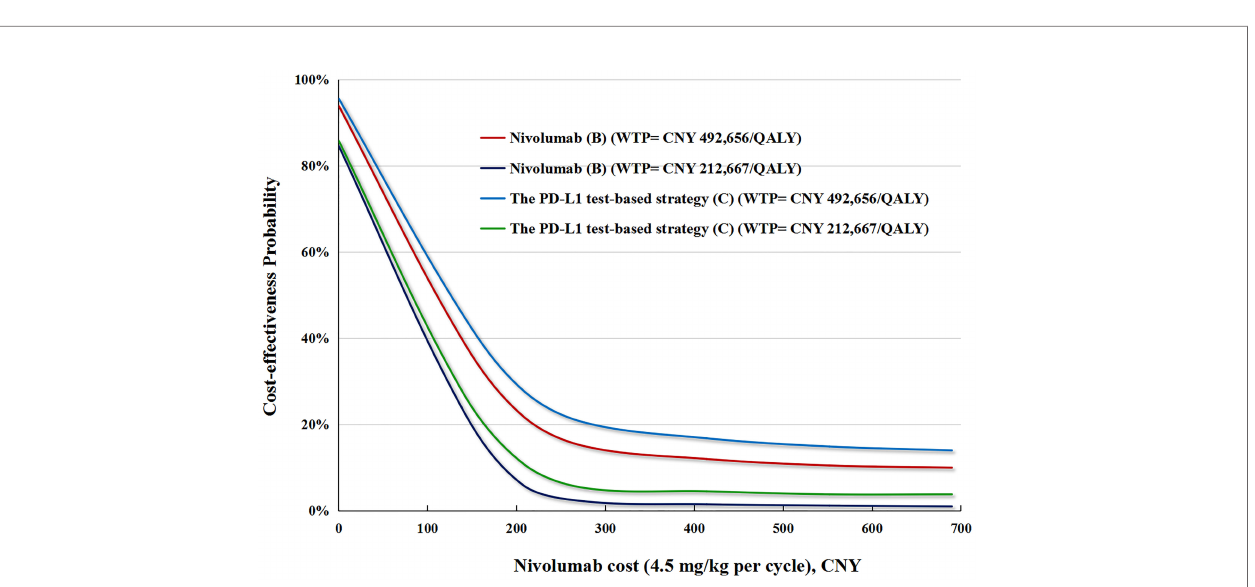
FIGURE 5 | The cost-effectiveness probability achieved by the PD-L1 test-based strategy (C) and nivolumab (B) compared to docetaxel (A) at different nivolumab prices. QALY, quality adjusted life-year; WTP, willingness-to-pay; PD-L1, programmed death